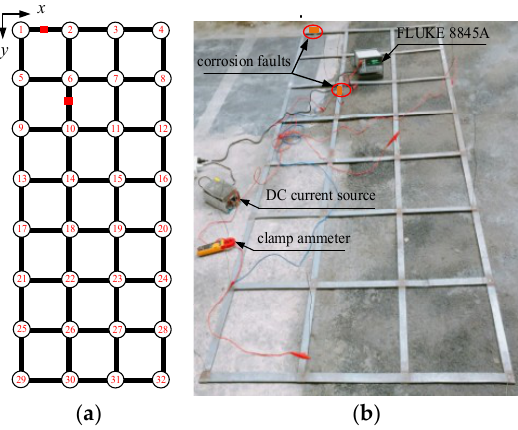
Figure 11. The experimental picture. ( a ) The simulated grounding grid model; ( b ) The experiment picture.